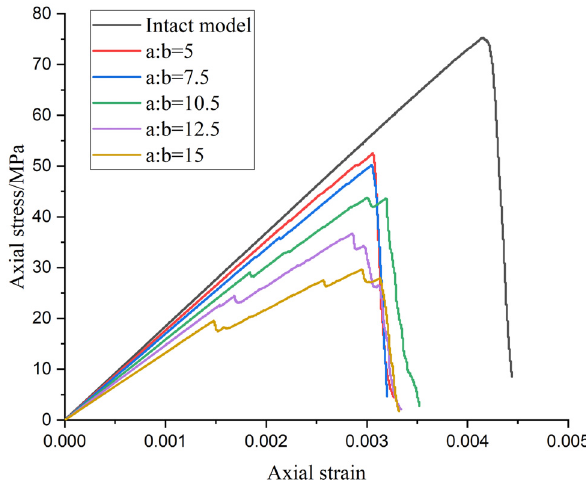
Figure 4: Stress – strain curves of six numerical models.